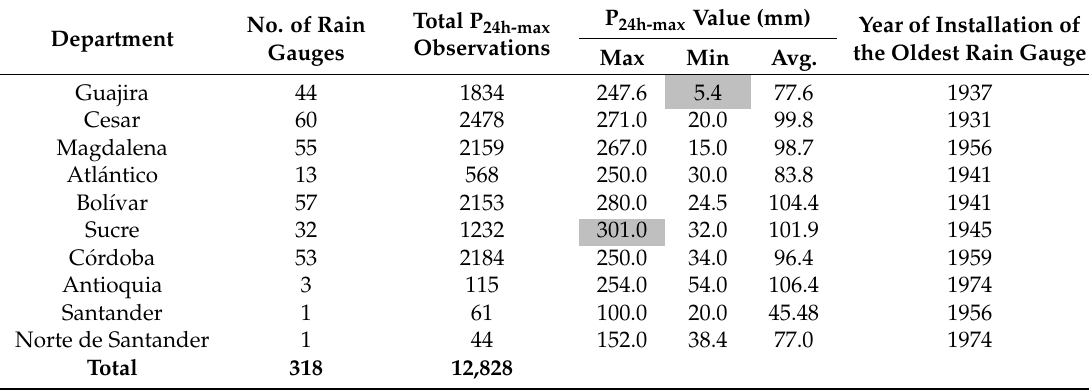
Table 1. Summary of rainfall data analyzed.